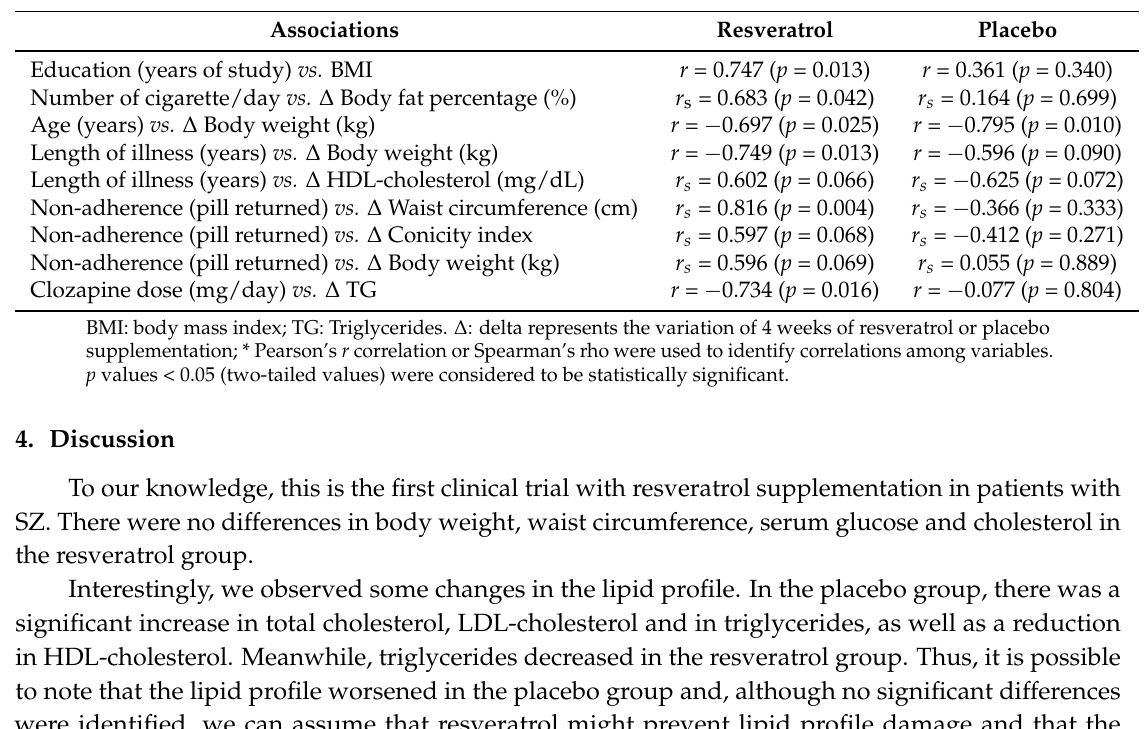
Table 4. Significant correlations in 4 weeks of resveratrol supplementation or placebo. Correlation Coefficient Associations Resveratrol